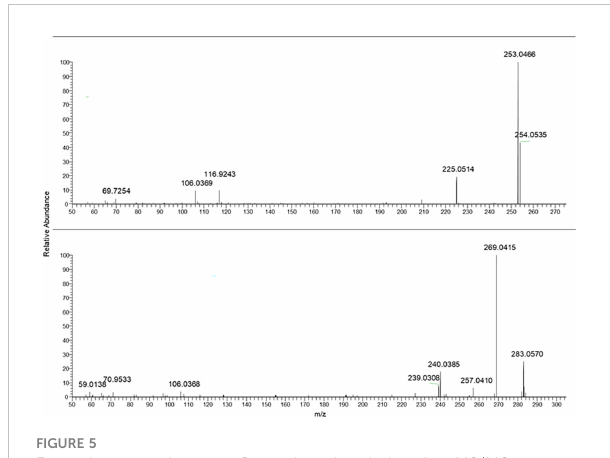
FIGURE 5 From the top to bottom: Crysophanol and physcion MS/MS